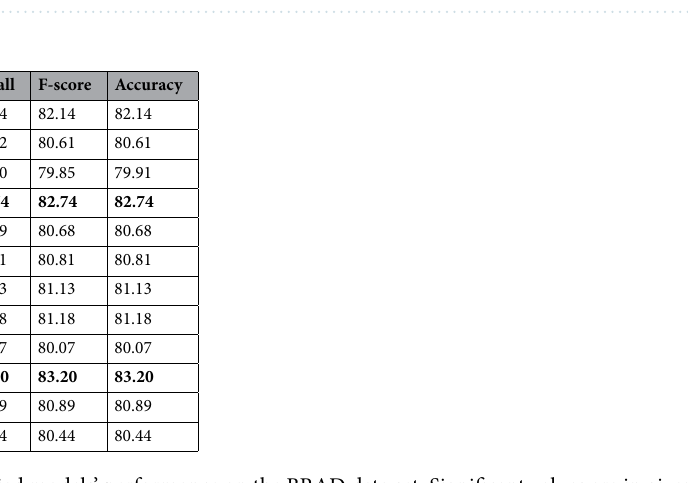
Table 6. Comparison of applied models’ performance on the BRAD data set. Significant values are in given in bold.